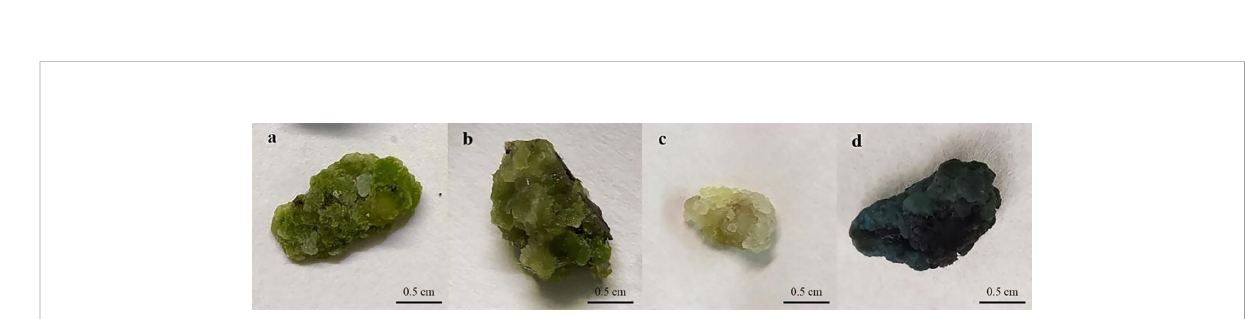
FIGURE 5 Genetic transformation of P. lacti fl ora callus by Agrobacterium -mediated transformation. (A) callus before Agrobacterium infection, (B) callus after Agrobacterium infection, (C) GUS expression in control callus, (D) GUS expression in transgenic callus.